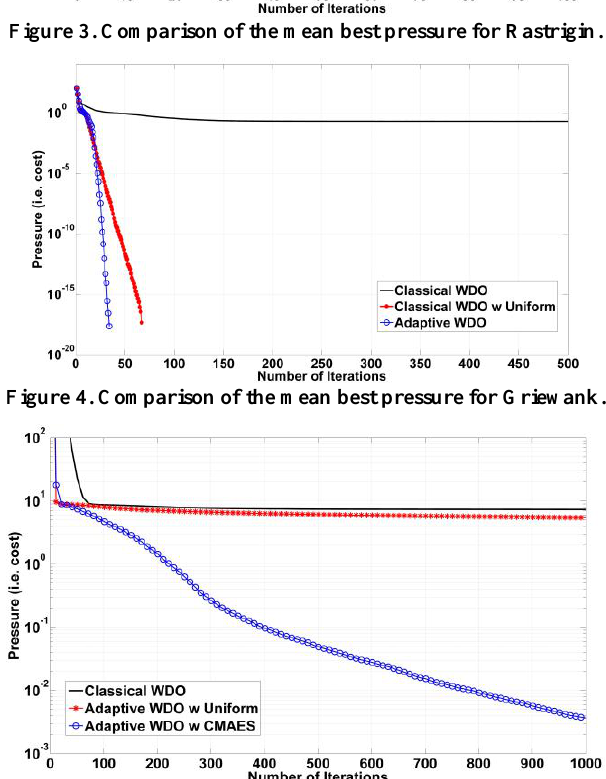
Figure 3. Comparison of the mean best pressure for Rastrigin.